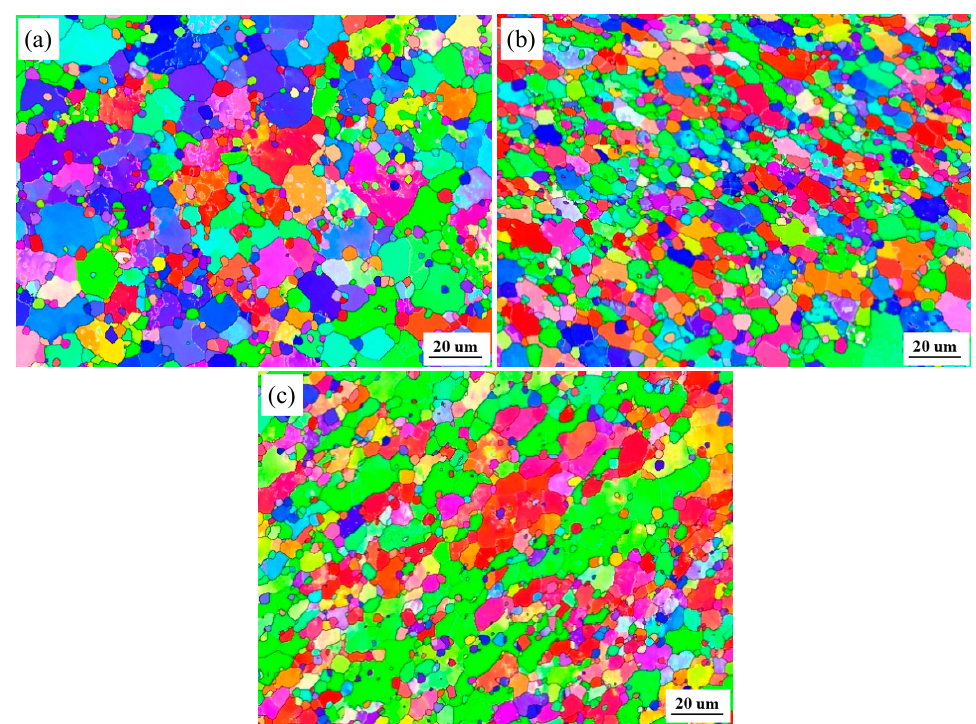
Figure 7. Electron backscattering di ff raction (EBSD) maps at the NZs of FSW joints under di ff erent states: ( a ) T1; ( b ) T4; ( c ) T6.